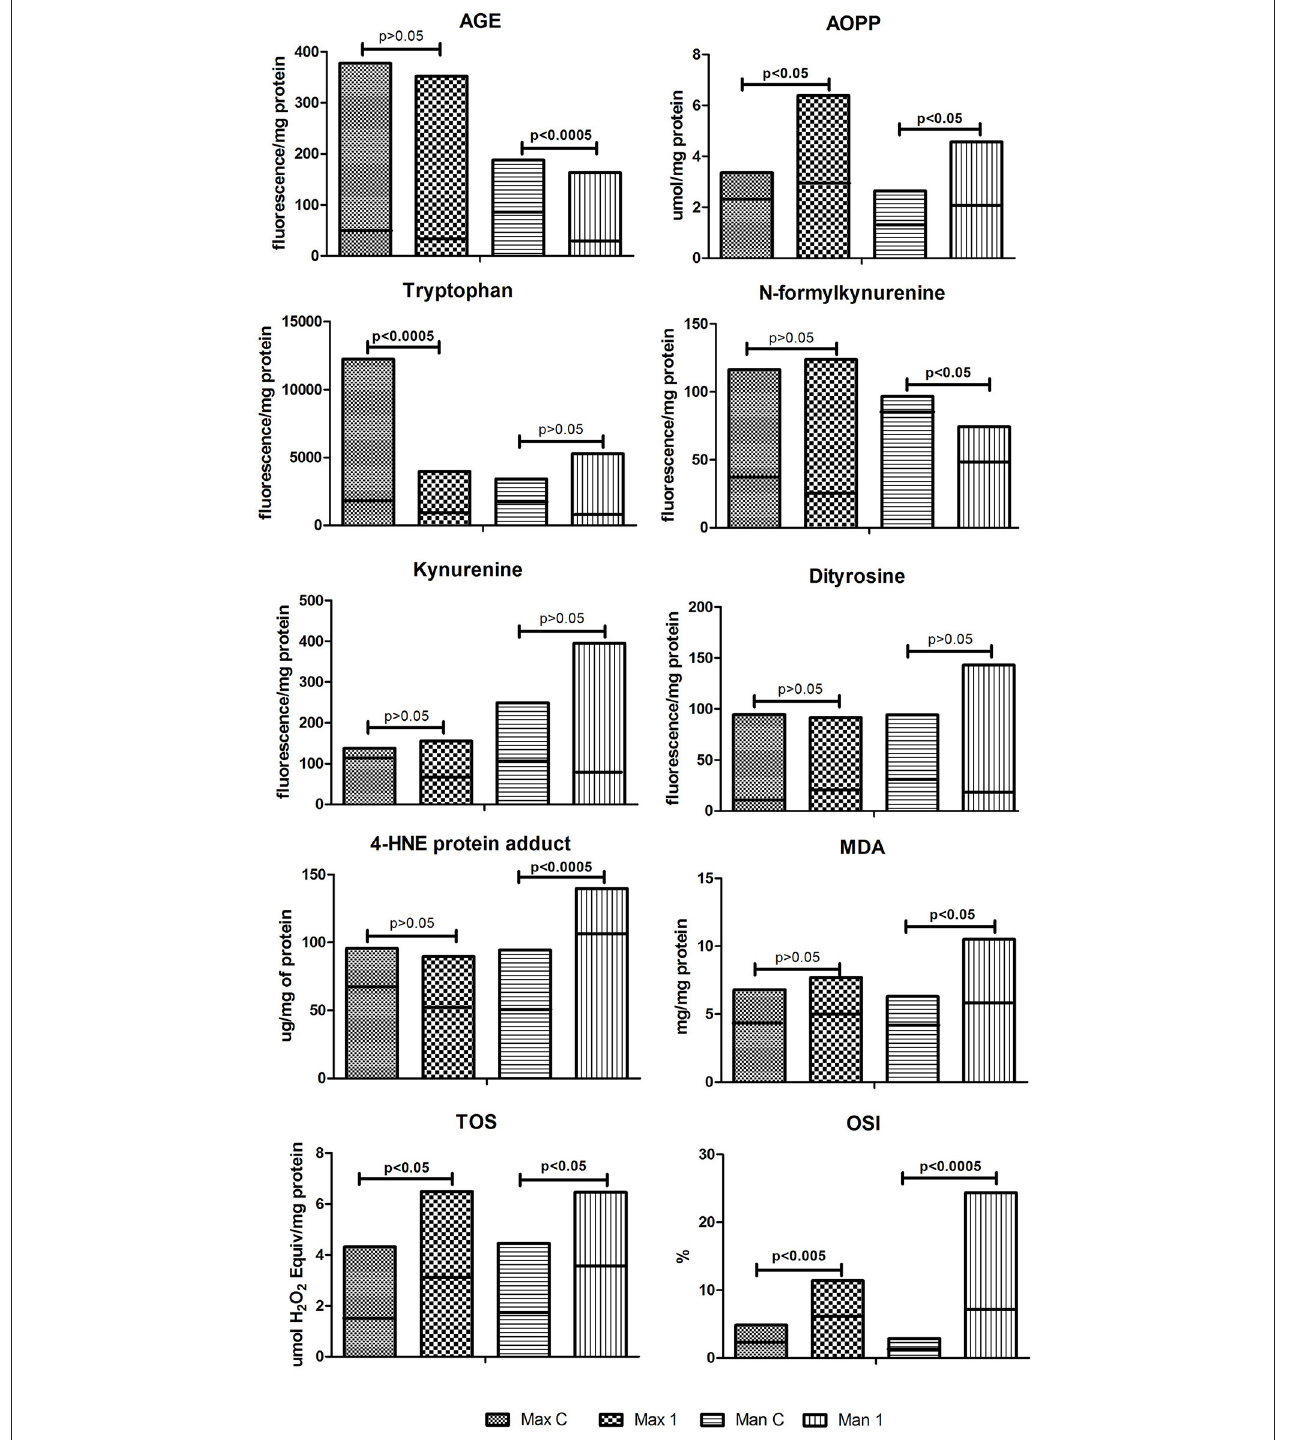
FIGURE 3 | Oxidative modification products and markers of oxidative stress in the control and examined tissue homogenates. Max C, maxilla control; Man C, mandibula control; Max 1, maxilla of the study group; Man 1, mandibula of the study group; AGE, advanced glycation end products; AOPP, advanced oxidation protein products; MDA, malondialdehyde; TOC, total oxidant capacity; OSI, oxidative status index. Horizontal line on the chart indicated the median.